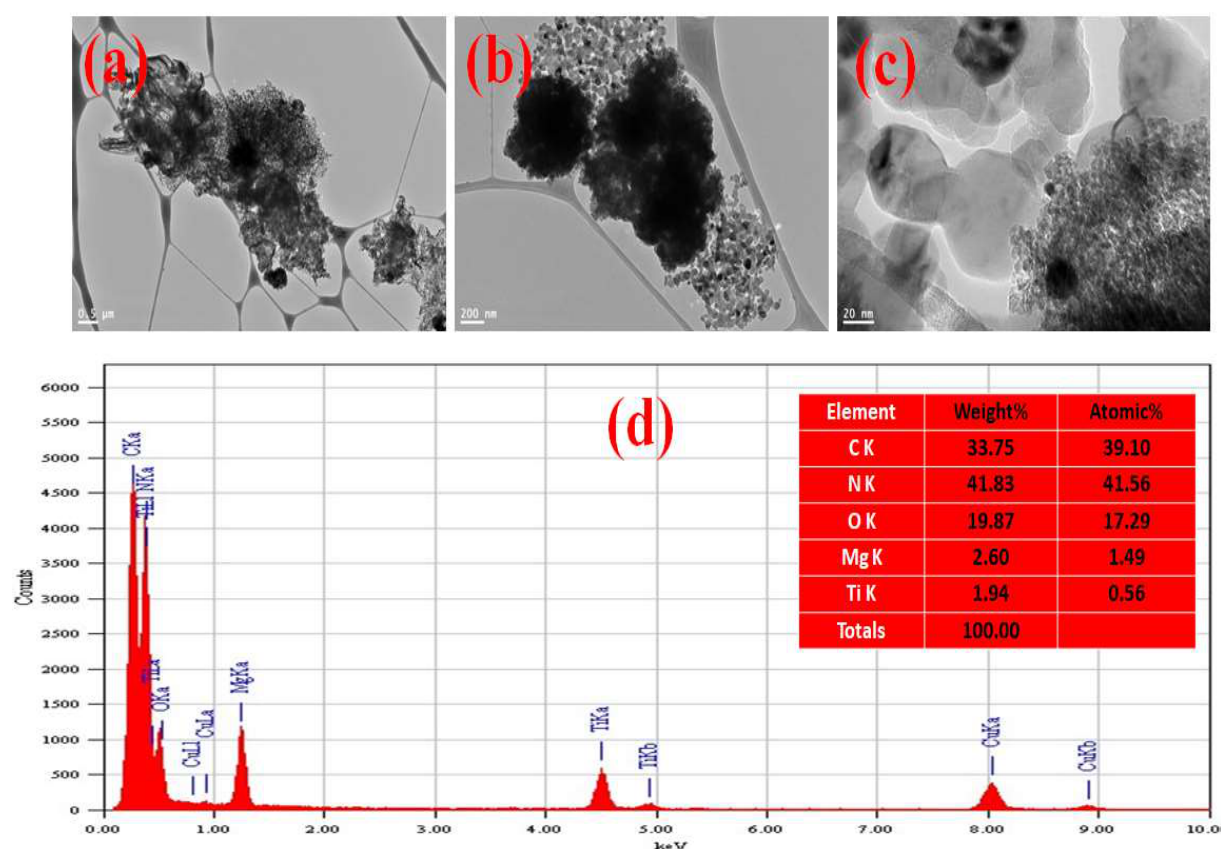
Inorganics 2022 , 10 , x FOR PEER REVIEW 4 of 16 Figure 1. ( a – c ) TEM results of MgTiO 3 @g-C 3 N 4 nanohybrids from different spots; ( d ) EDS obtaining for the synthesized MgTiO 3 @g-C 3 N 4 nanohybrids.